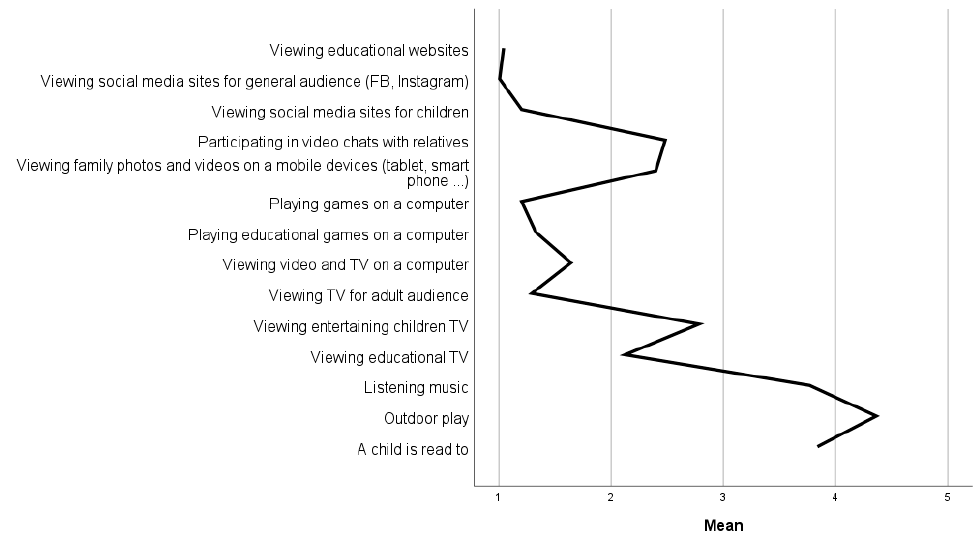
Figure 7. Parents’ estimation of child’s daily playtime